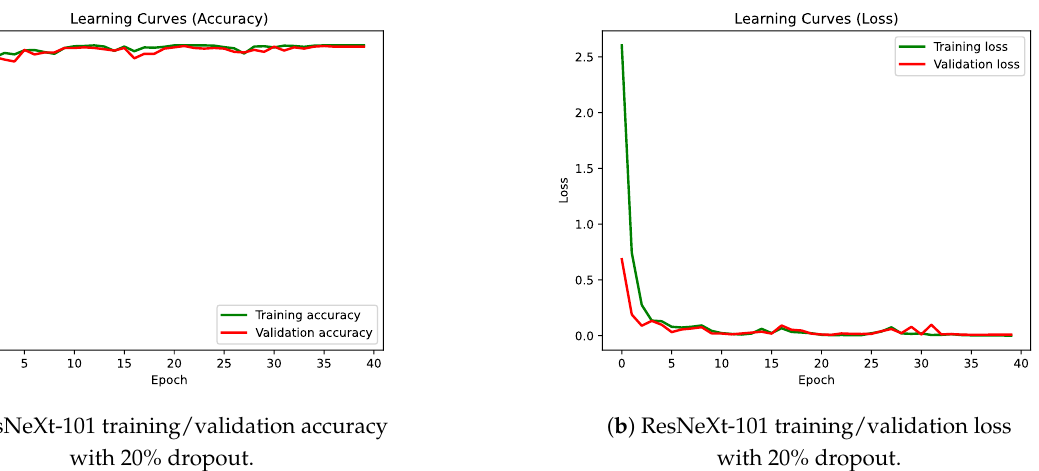
Figure 7. ResNeXt-101 training with 20% dropout.